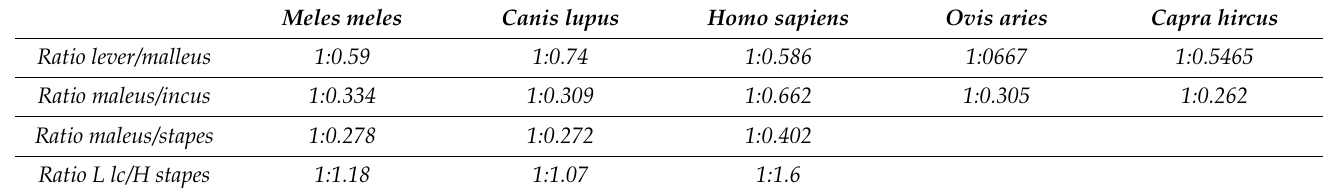
Table 2. Comparison of combined numerical data for the badger, wolf and